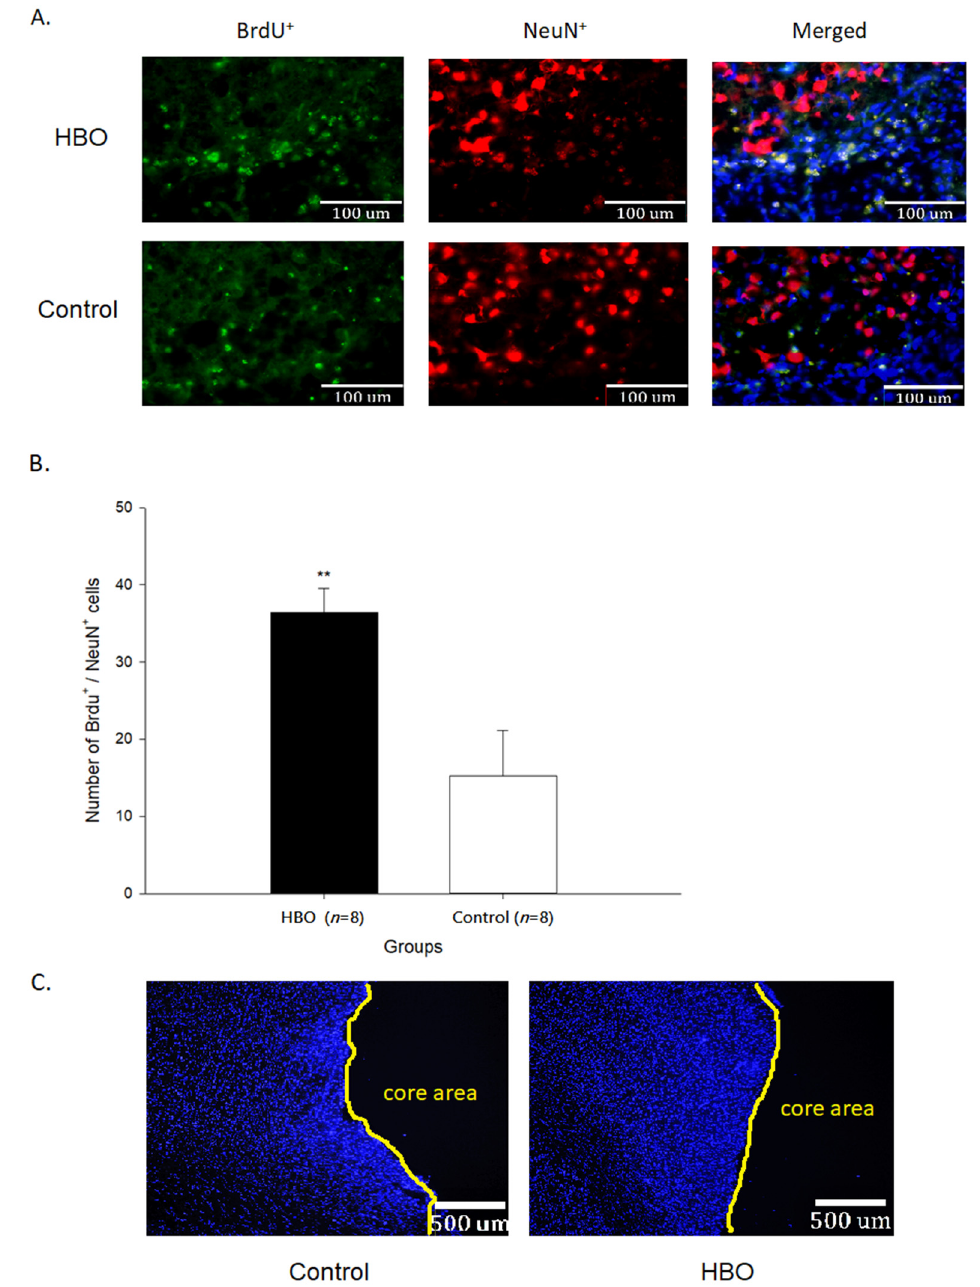
Figure 5. ( A ) The immunofluorescence imaging of BrdU + (green) and NeuN + (red) cells in the penumbra area between groups (under 40 × objective lens). ( B ) The quantifications of BrdU + /NeuN + cells in the penumbra area between groups. ( C ) Illustration of penumbra and core area boundaries (under 5× objective lens). Nuclei stained with DAPI (blue). **, p < 0.01. HBO: hyperbaric oxygen.